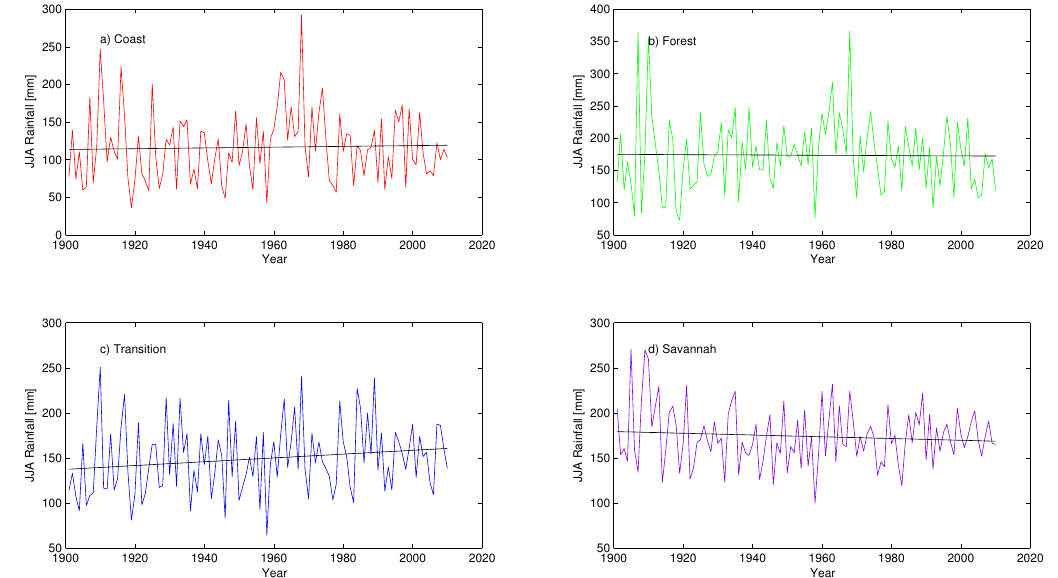
Figure 15. ( a – d ) Long-term course of seasonal rainfall overthe agro-ecological zones of Ghana for JJA.